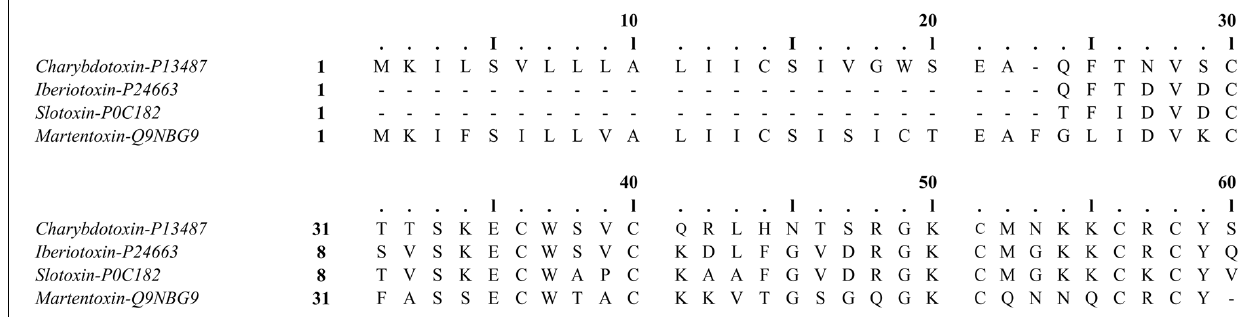
FIGURE 5 | Sequence alignment of the ChTX family of K + toxins. Using MUSCLE software (Edgar, 2004). UniProt protein accession: Charybdotoxin, P13487; Iberiotoxin, P24663; Slotoxin, P0C182; Martentoxin,